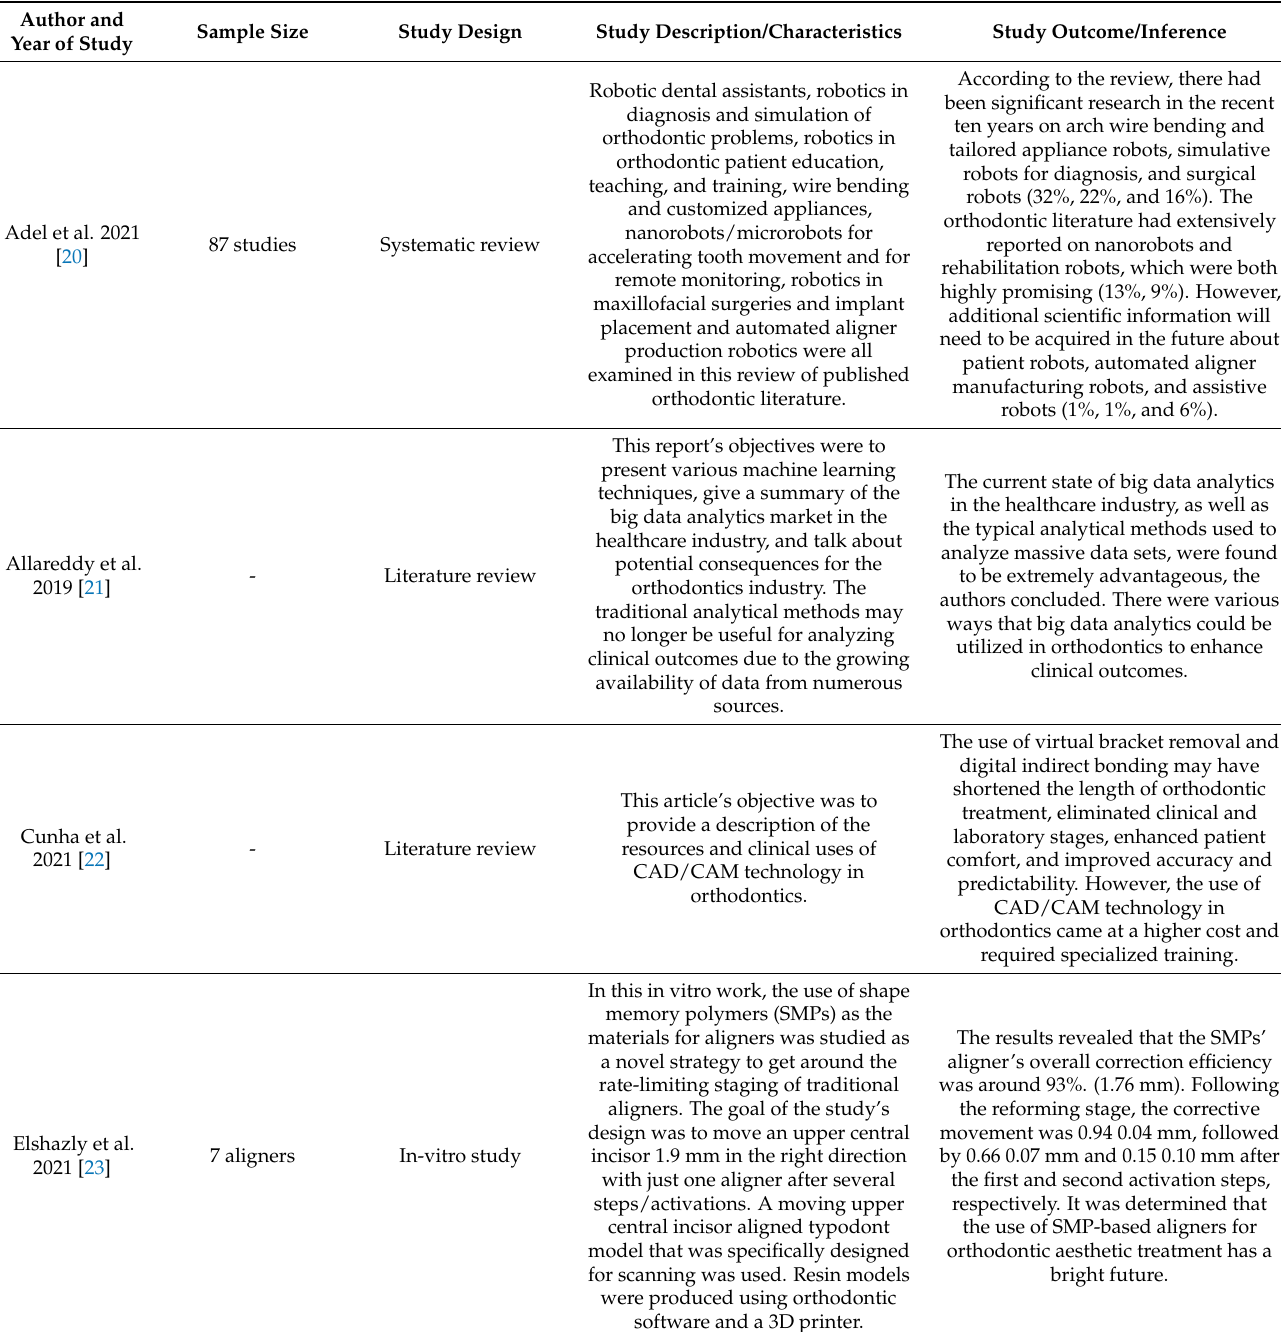
Table 2. Description and outcomes as observed in the studies selected for the systematic